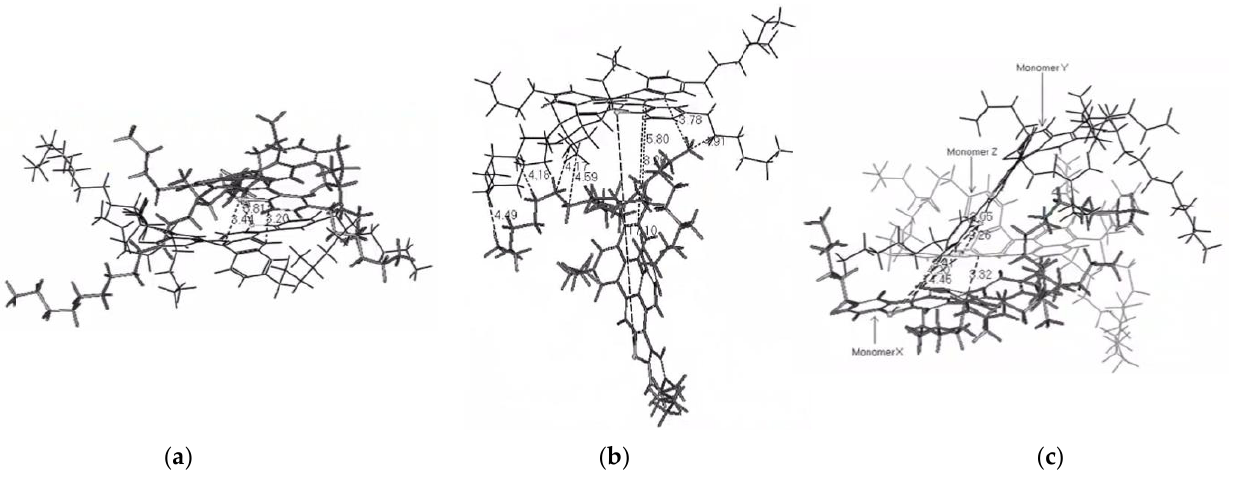
Figure 4. Three kinds of different stacking methods of aromatic rings. ( a ) Face – face stacking, ( b ) edge-on or T-shaped stacking, and ( c ) offset stacking.